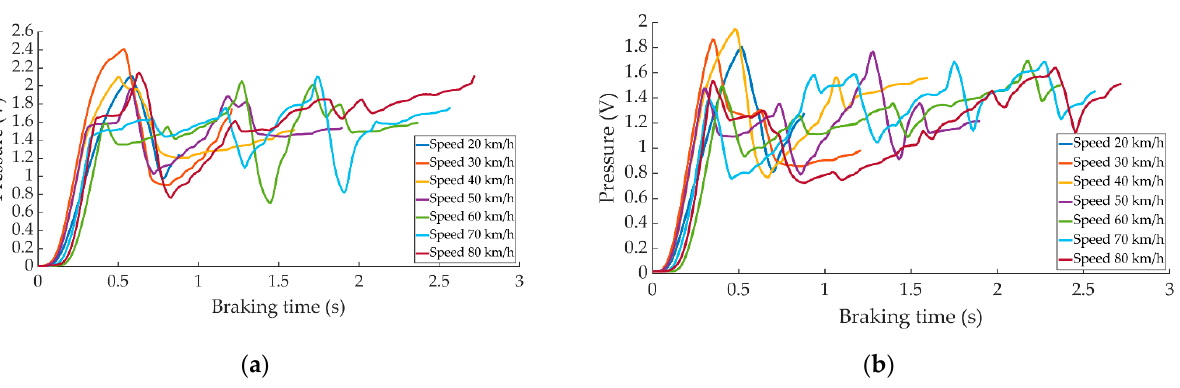
Figure 8. Curves of the data obtained during emergency braking for the different speeds by ( a ) the right pressure sensor and ( b ) left pressure sensor.